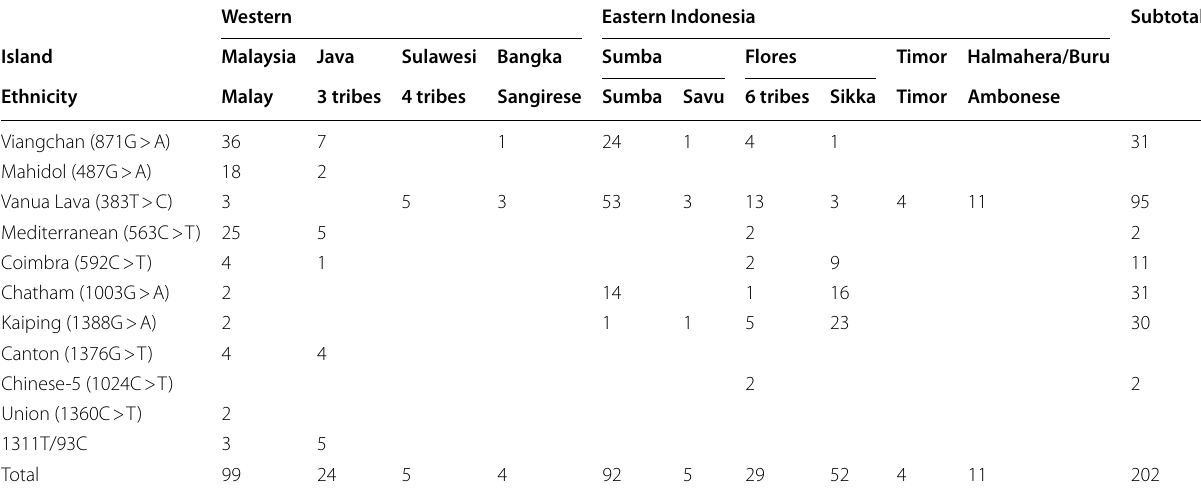
Data of Java islanders are reported from [7, 41, 42] and data of eastern Indonesian populations from [7, 8, 11, 13,